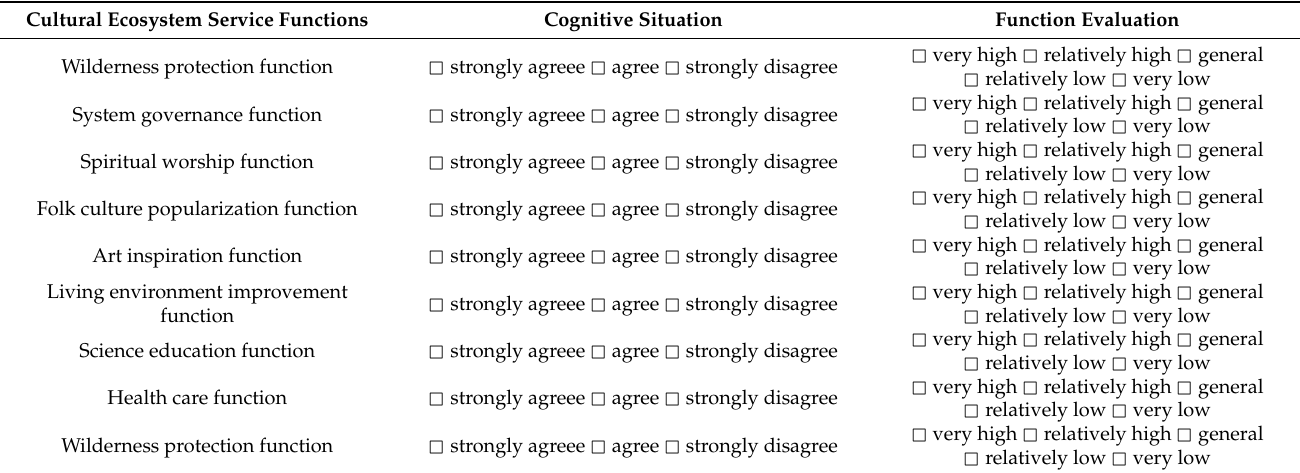
Table A1. Cognition of cultural ecosystem service